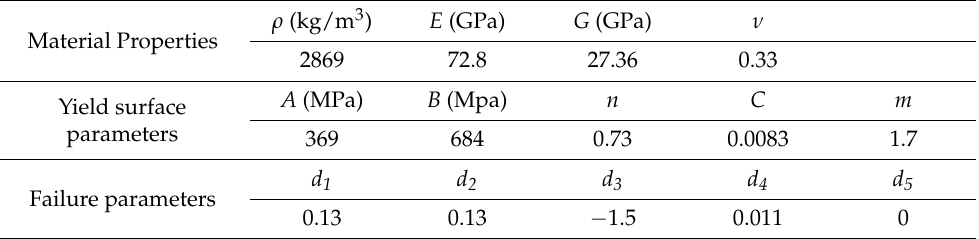
Table 1. Material properties of aluminium 2024-T3 for Johnson–Cook material model [29–31].